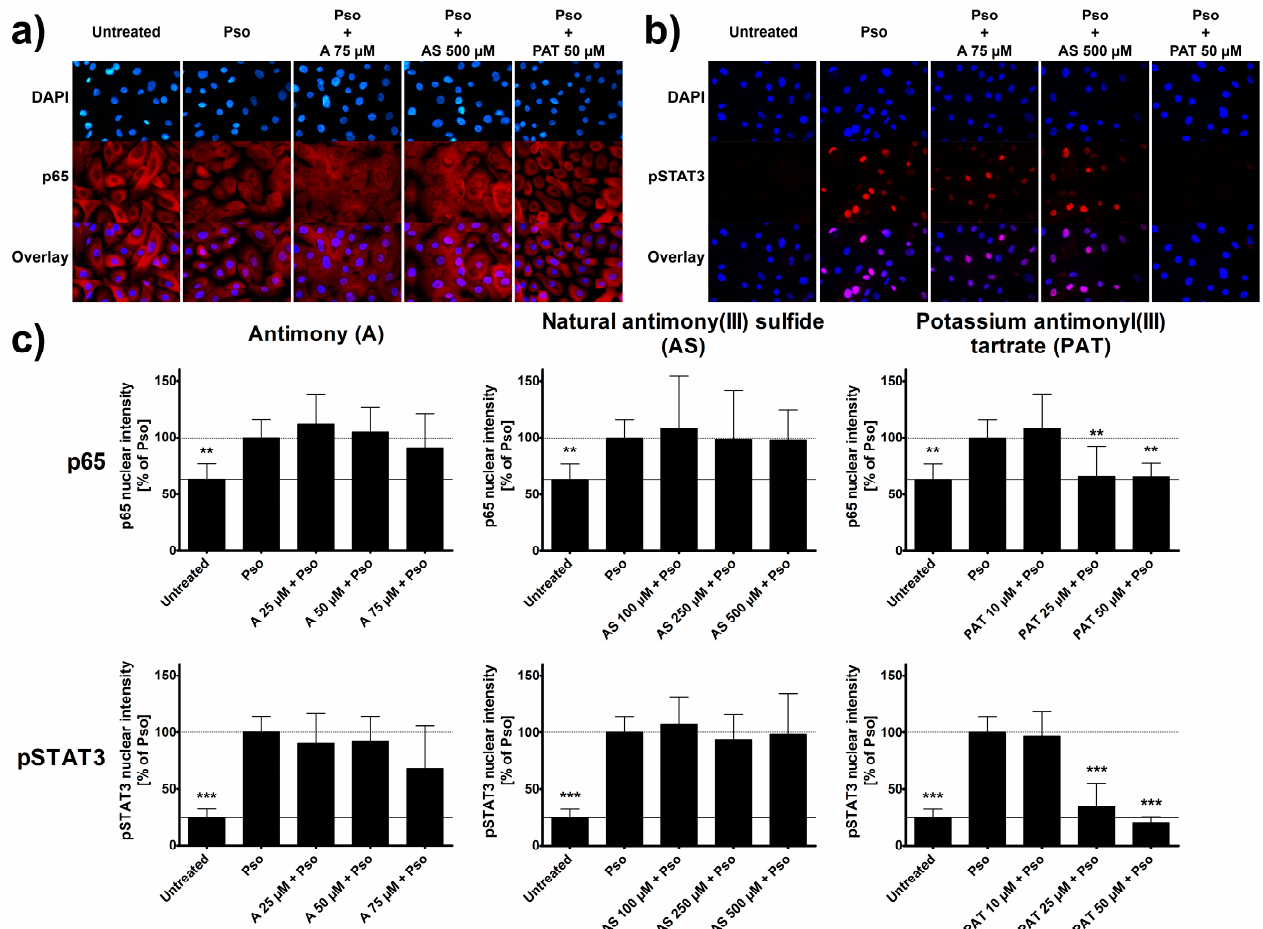
Figure 3. Effect of ACs on the activation of NF- κ B and STAT3 signaling pathways. PHKs were stimulated with the Pso cytokine combination (20 ng/mL of IL-17A, IL-22 and TNF- α ) for 30 min with or without pre-treatment of A, AS or PAT for 2 h and immunofluorescence staining of the p65 subunit of NF- κ B and pSTAT3 were performed. The nucleus is stained with DAPI. Representative pictures of ( a ) p65 and ( b ) pSTAT3 staining in untreated, Pso-treated and AC treated cells. ( c ) The intensity of the staining in the nucleus was measured using the Intensity Ratio Nuclei Cytoplasm Tool (RRID:SCR_018573) in ImageJ. Data shown as mean ± SD of four independent experiments with two pictures per experiment. Statistical analysis was performed using one-way ANOVA with Newman–Keuls post-test comparing the samples to Pso stimulation. * p ≤ 0.05, ** p ≤ 0.01, *** p ≤ 0.001.